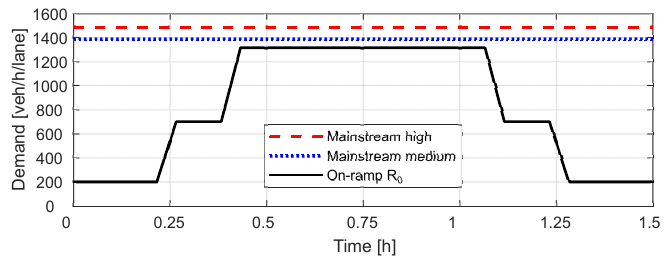
Figure 3. Tested traffic